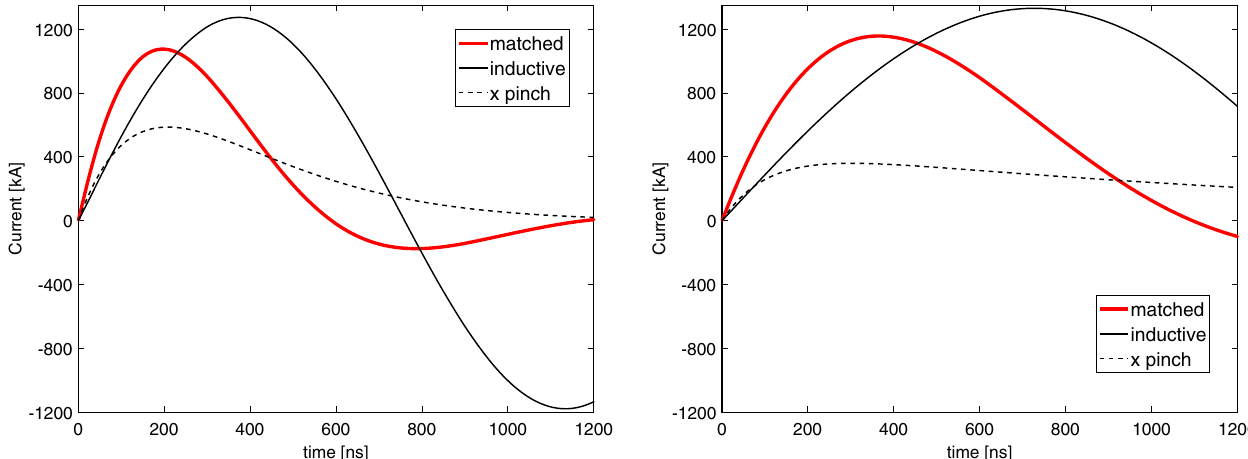
FIG. 8. Simulated output currents into matched, inductive, and x-pinch loads for a 40-brick standard pulser (left) and a 40-brick dry pulser (right). Both systems include a 12-nH